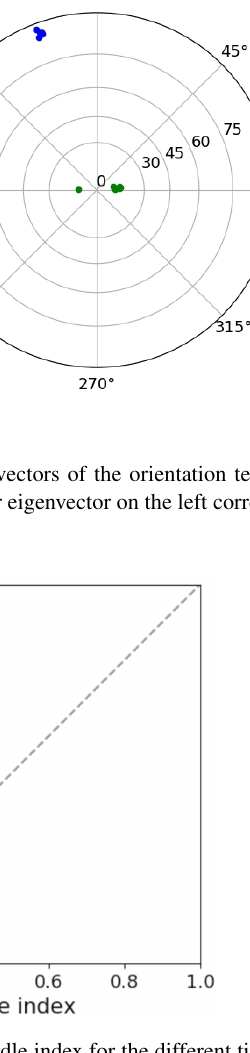
Figure 13. Cluster index versus girdle index for the different times indicated. Grey dashed line represents the y = x line.